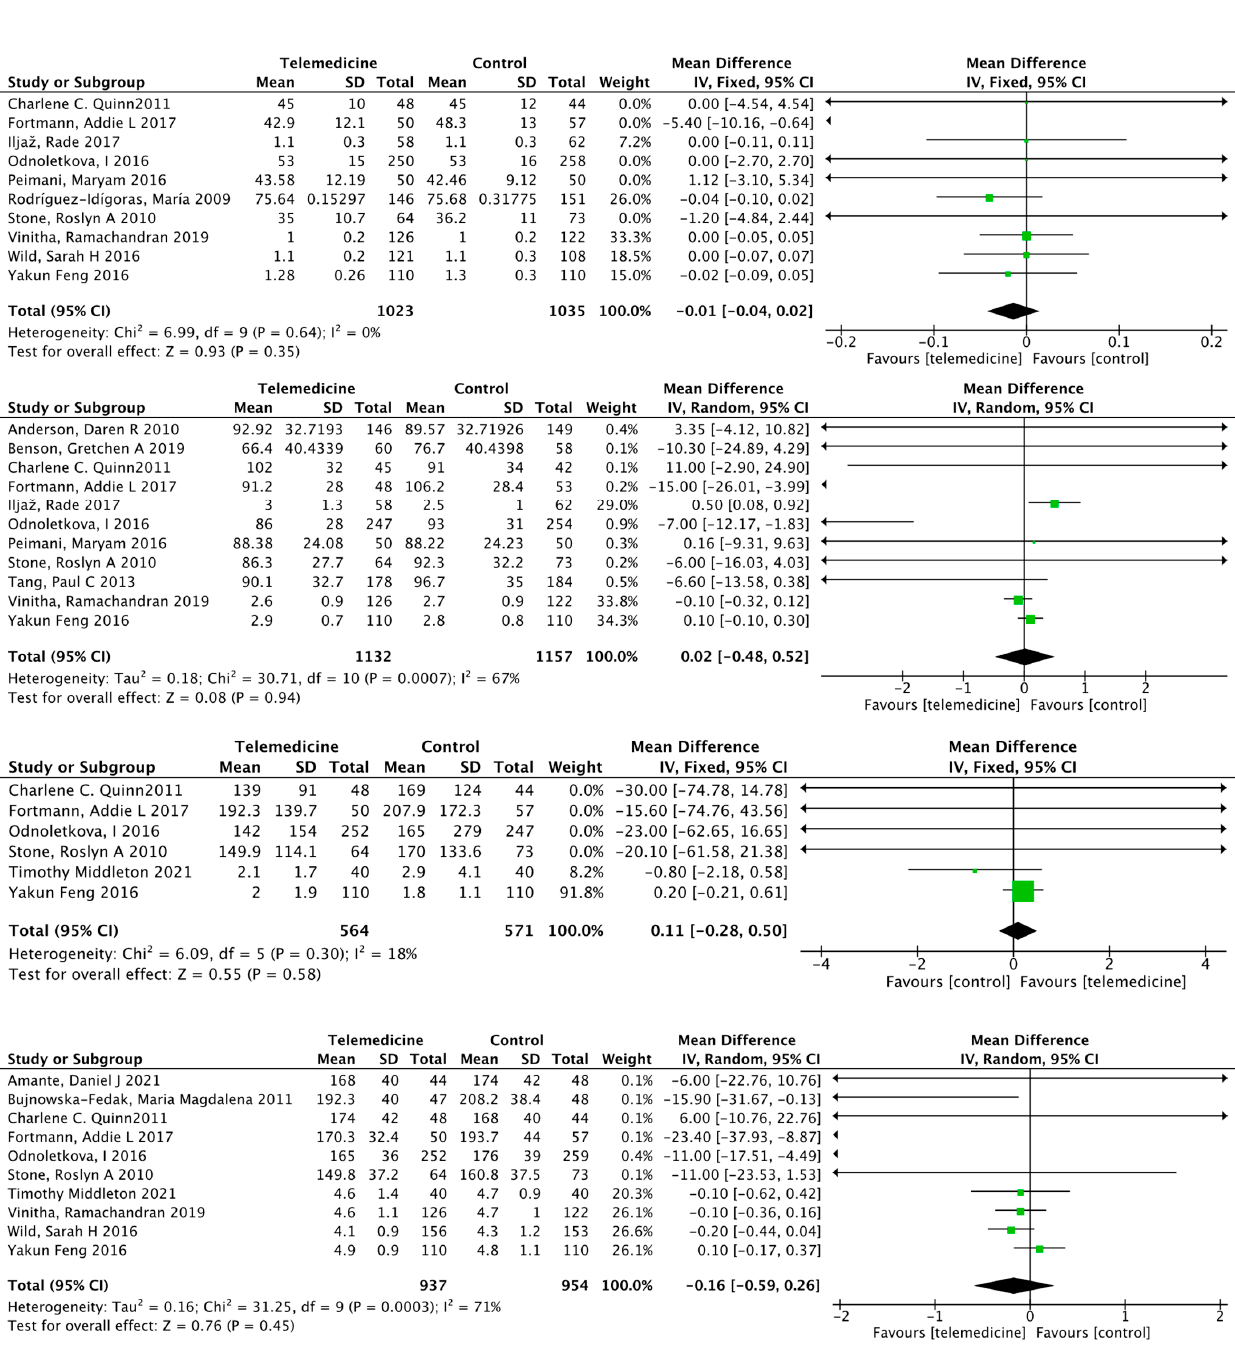
Figure 10. Mean difference in the changes in HDL, LDL, TG, and TC levels for telemedicine and usual care interventions.